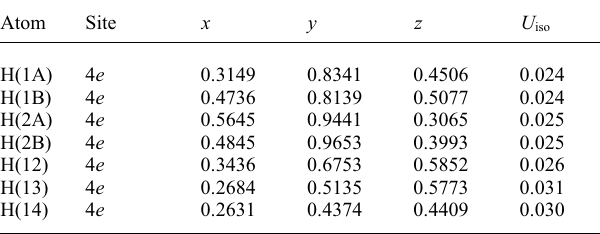
Table 2. Atomic coordinates and displacement parameters (in Å 2 )